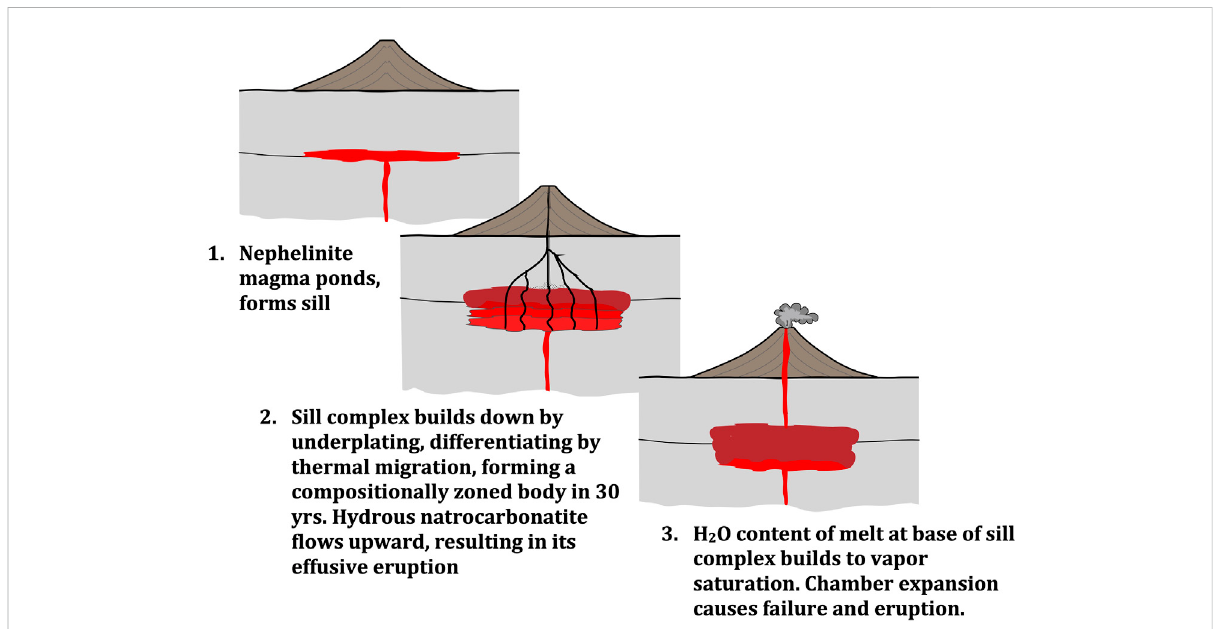
FIGURE 9 Cartoon depicting stagesin thetemporal evolution and ~30 years eruption cycles of Ol Doinyo Lengai volcano. In stage 1,nephelinite magmas begin to pond in the upper crust after encountering a permeability barrier. Next, sills build down with time forming a moving temperature gradient zone that forms a compositionally zoned mush body. During this time, H 2 O-Na 2 CO 3 liquid ascends through the mush and effusively erupts — degassing ofH 2 Ofrom thisliquid at low pressure results intheanhydrous natrocarbonatiteobserved. Finally, as thissill complex grows top down, H 2 O dissolved in silicate melt builds up in the nephelinite that occurs at the arriving sill/base of the system. At ODL, the rise in melt H 2 O content occurs over a 30 years time scale, ultimately resulting in H 2 O vapor saturation that drives explosive eruption of the silicate magma by carapace failure (vertical scale of sill complex is exaggerated for clarity). Vertical scale approximate (sill thickness exaggerated and depth of sill complex is not speci fi